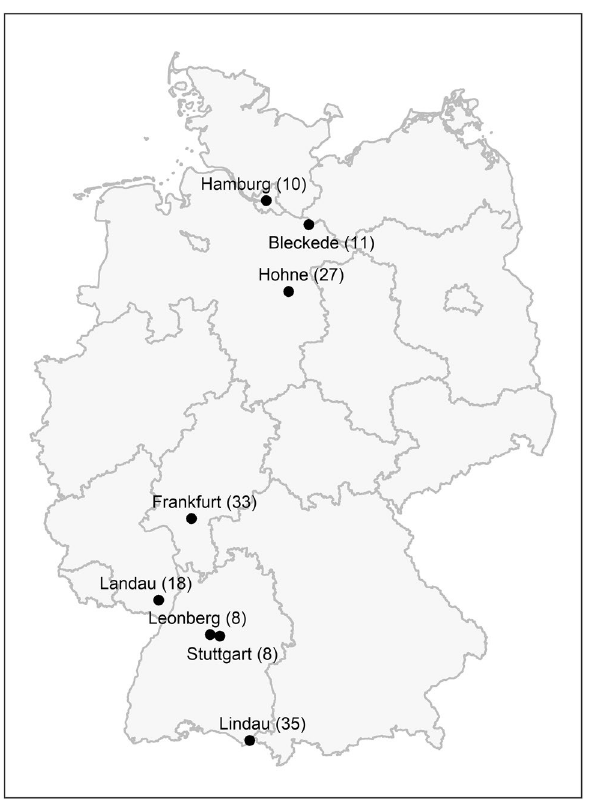
Figure 1. Sampling locations of stray cats in Germany. (N) indicates the number of stray cats genotyped at each sampling location. The map was created using raster of the R package, version 3.5–29 (https:// CRAN.R- proje ct. org/ packa ge=